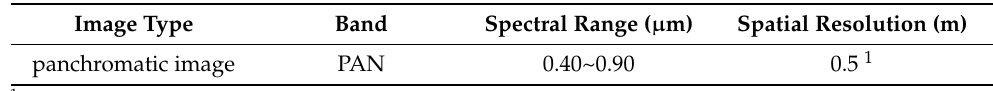
Table 1. WorldView-1 satellite image parameters.